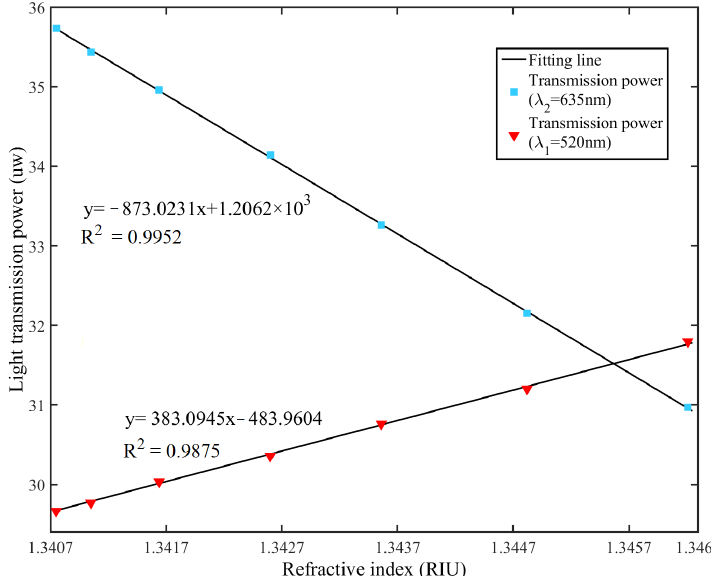
Figure 9. The output signal of the dual wavelengths versus RI.